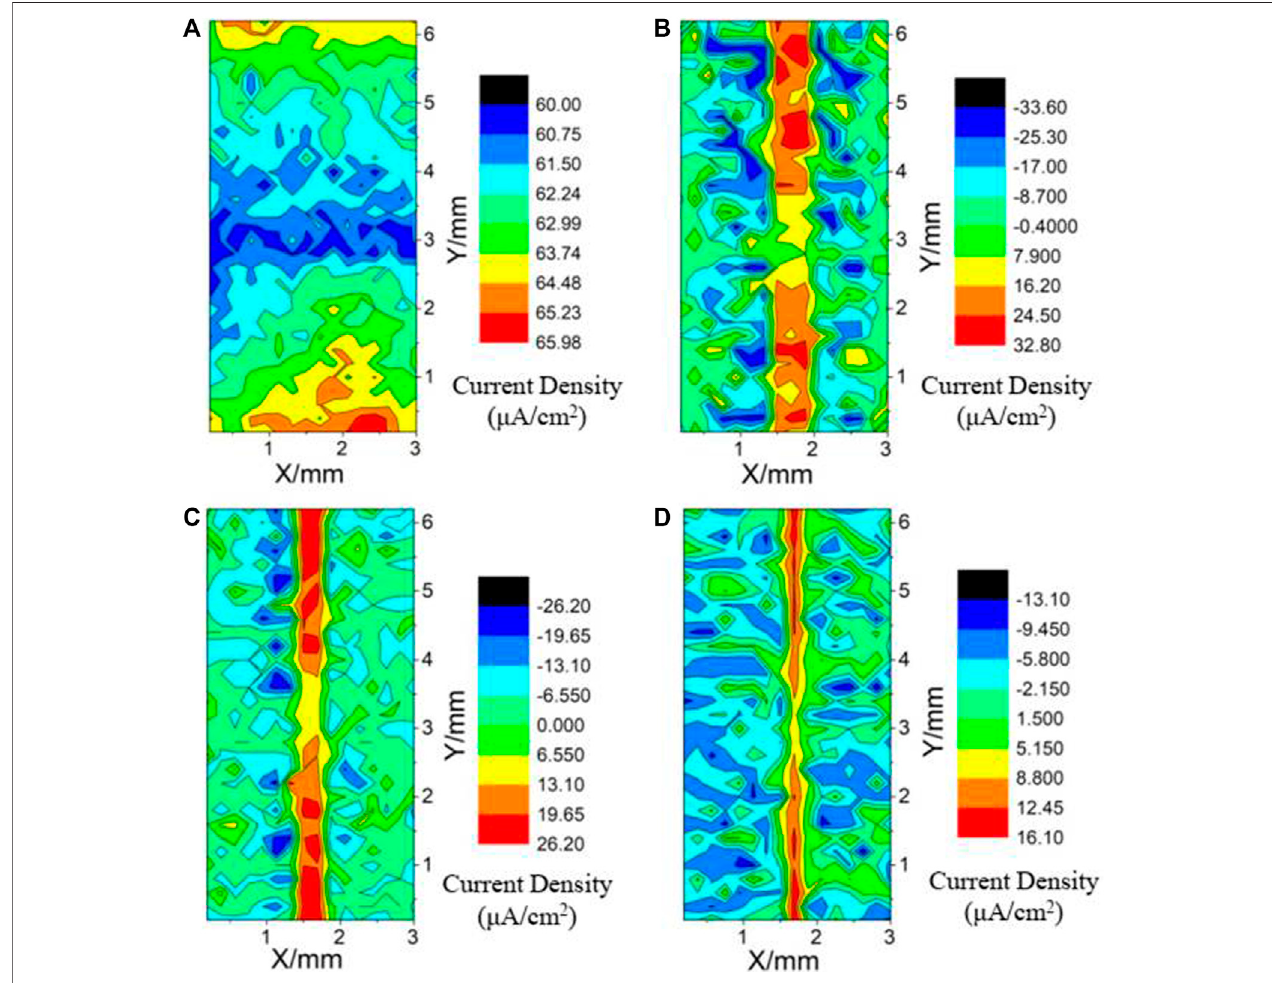
FIGURE 11 | SVET maps of samples after immersion in a 3.5 wt% NaCl solution [ (A) FSW joint; (B) 50% duty ratio; (C) 80% duty ratio; (D) 100% duty ratio].